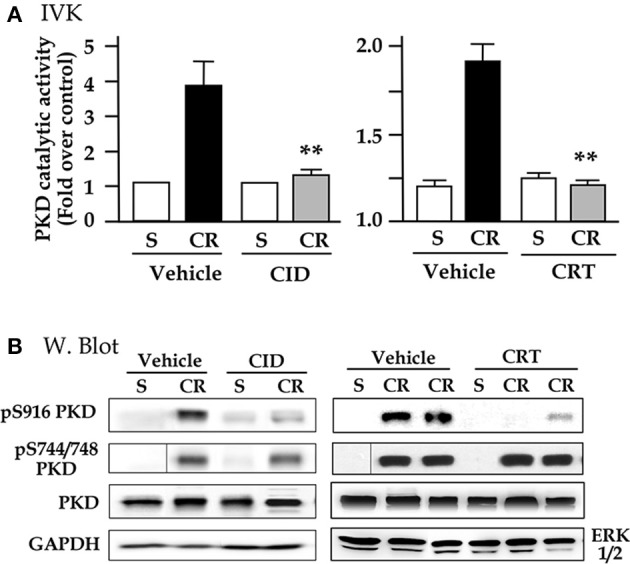
CID755673 or CRT 0066101 pretreatment inhibits PKD activation in cerulein-induced experimental pancreatitis. Rats received intraperitoneal (IP) injection of CID755673 (CID, 15 mg/kg) or CRT 0066101 (CRT, 10 mg/kg). Control rats received same volume of vehicle DMSO. After 60 min waiting time, the inhibitor- or vehicle-pretreated animals were given an IP injection of cerulean (CR) or saline (S). The pancreas was collected in 30 min after the cerulein or saline injection. (A) The pancreas tissue lysates were immunoprecipitated with PKD/PKD1 C-20 antibody and PKD1 activity in the immunocomplexes was determined by in vitro kinase assay (IVK). PKD/PKD1 catalytic activities were expressed increased fold over control in the animals injected with saline. Results are means ± SE (n = 3–5) for each condition. **p < 0.01 vs. cerulein alone without inhibitor pre-treatments. (B) Western blot was performed to analyze PKD phosphorylation in the tissue lysates using antibodies against phospho-Ser916 PKD, phospho-Ser744/748 PKD. PKD and GAPDH or ERK1/2: for loading controls. Samples were run in a single gel but were not continuous, as indicated by a line between lanes.